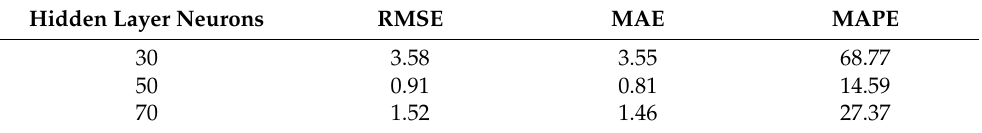
Table 3. The effect of the number of neurons in the hidden layer on the performance of the model. Hidden Layer Neurons